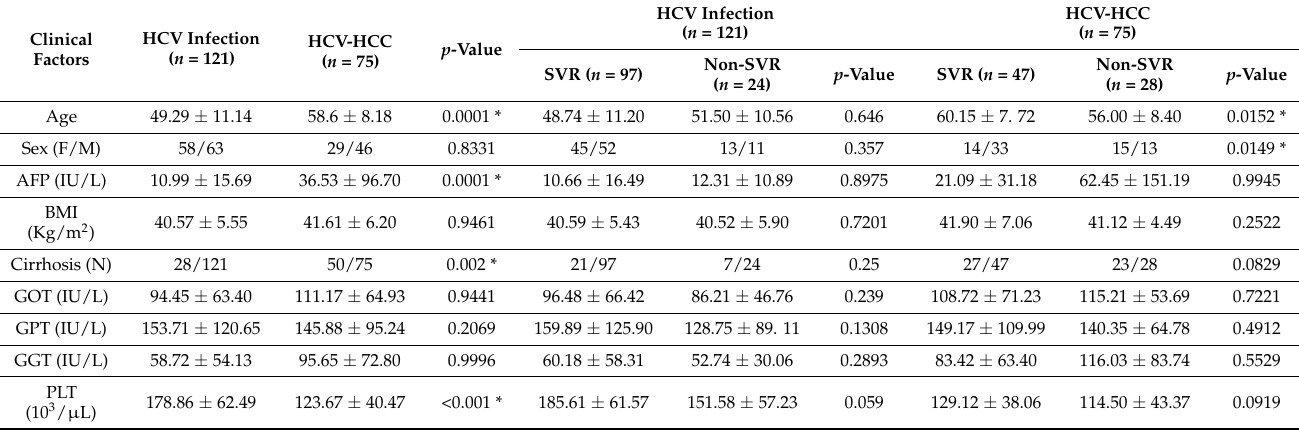
Table 3. Clinicopathological characteristics of HCV-HCC patients in a cohort treated with pegylated interferon (IFN). Clinical Factors